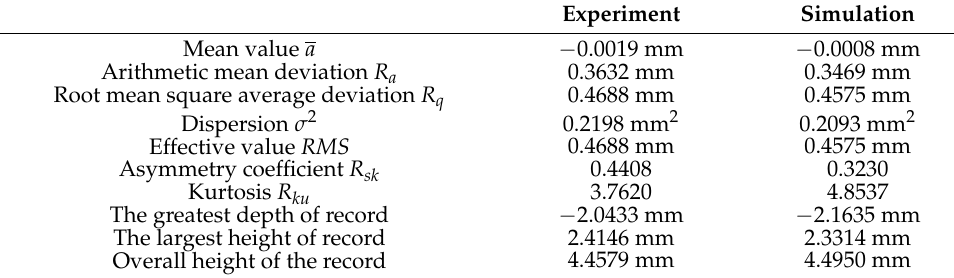
Table 2. Statistical characteristics of acceleration in vehicle CG.